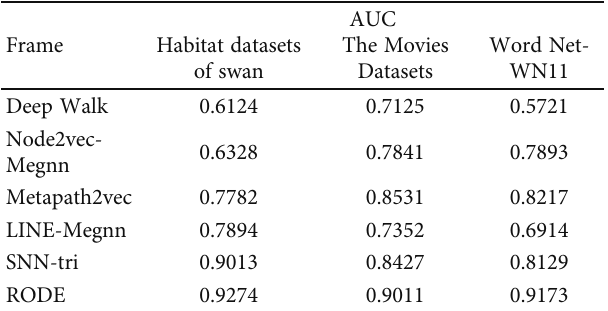
Table 2: Link prediction